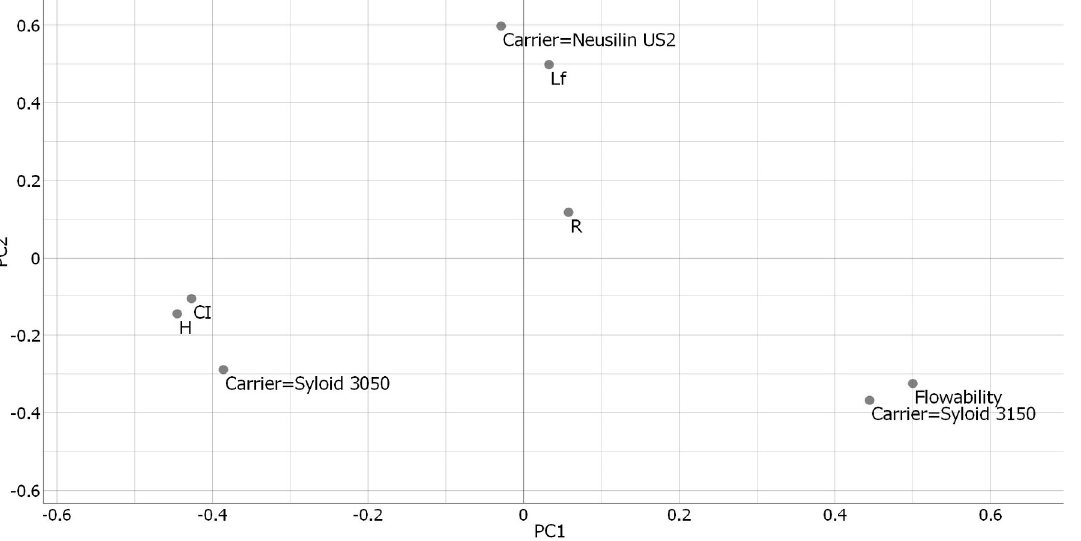
Table 2. Models tested during regression analysis. Model